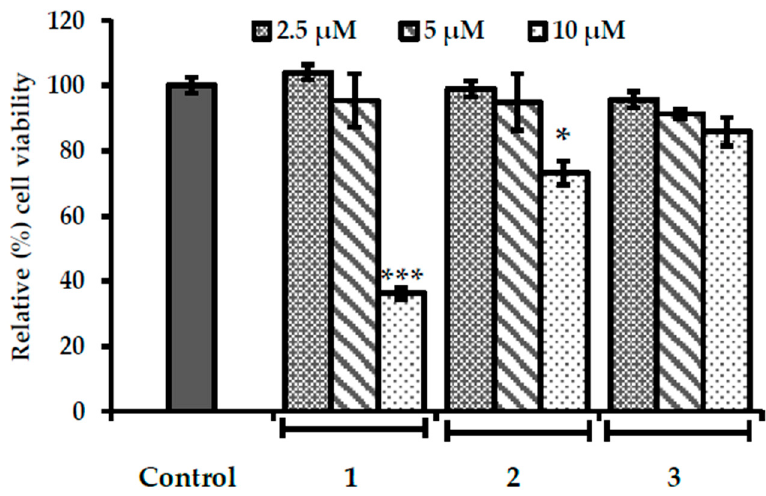
Figure 6. Effects of 1 – 3 on cell viability in HepG2 cells measured by MTT assay. Data shown represent means ± standard deviation of triplicate experiments. * p < 0.01 and *** p < 0.001 indicate significant differences from the control group.